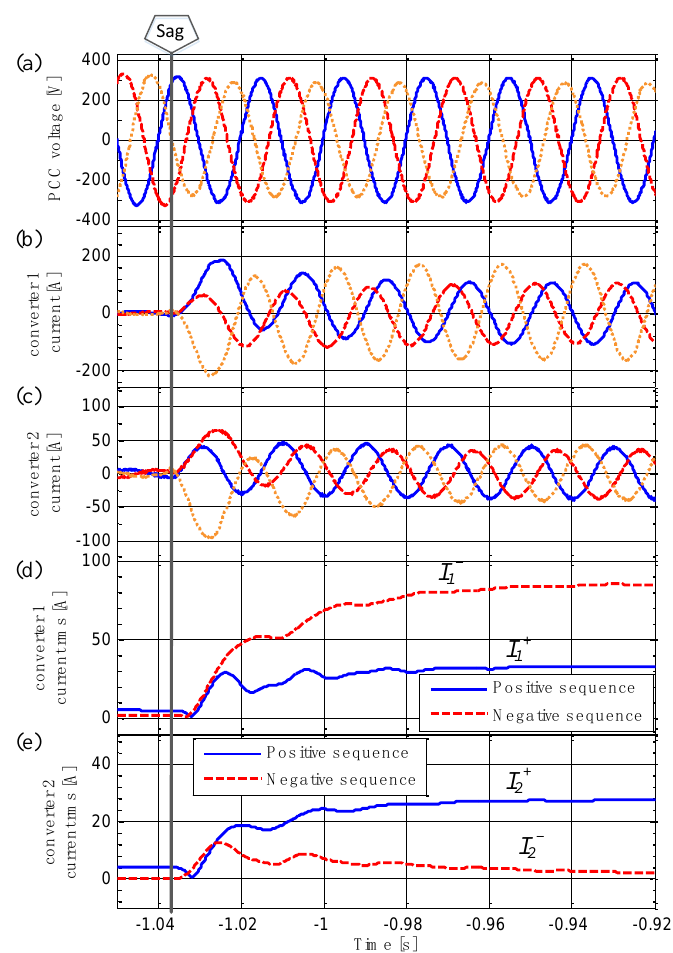
Figure 17. Two SPC-based power converters working with different negative-sequence virtual admittances. The transient responses after the start of an unbalanced sag: ( a ) voltage at the PCC; ( b ) current injected by the converter 1; ( c ) current injected by the converter 2; ( d ) rms of the positive- and negative-sequence current injected by the converter 1; and ( e ) rms of the positive- and negative-sequence current injected by the converter 1.